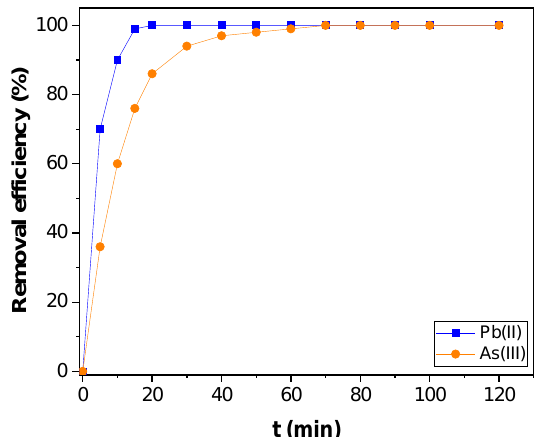
Figure 6. ( a ) Pseudo-first-order and ( b ) pseudo-second-order kinetics for Pb(II) adsorption over ox- idized CNTs, PAMAM and CNTs – PAMAM – Ag.